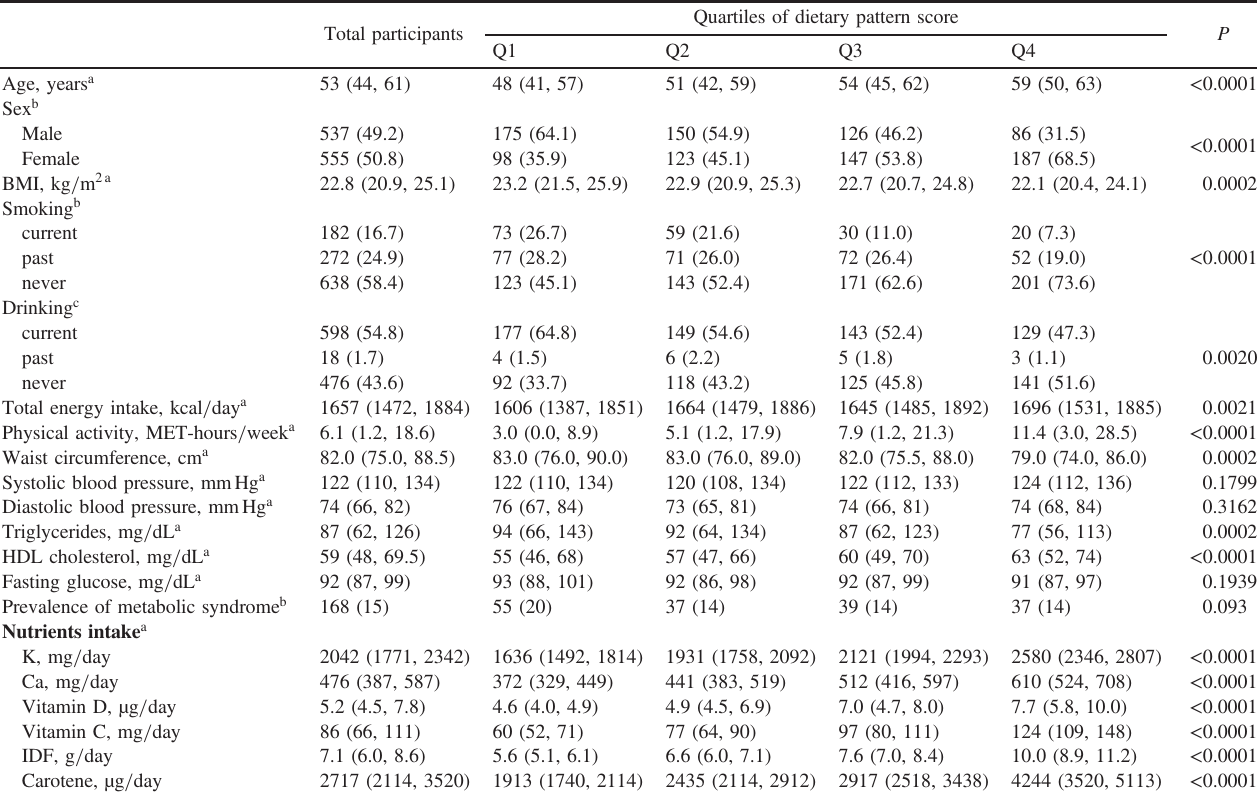
Table 3. Baseline characteristics of the study participants based on the quartiles of the dietary pattern 1 score Quartiles of dietary pattern score Total participants